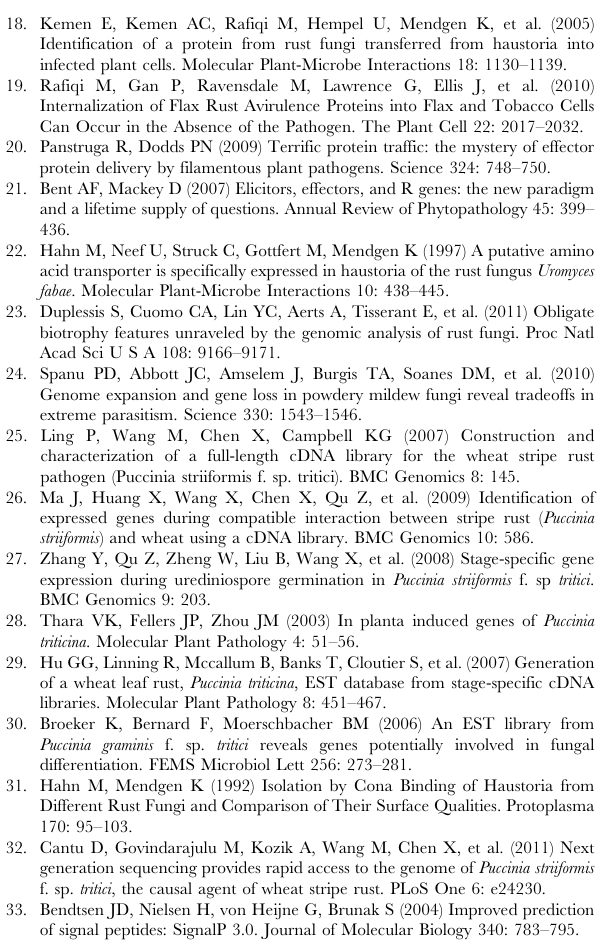
oxidative phosphorylation, and their in silico expression levels based on Illumina data are presented (RPKM values, green for haustoria and orange for germinated spores). Table S6 Gene expression values for the ontological analysis presented in Figure 4. Transcripts analysed with BLAST2GO and classed into different metabolic categories summarised in Figure 4 are listed in this table. The BLASTx values against the NCBI-nr protein database are included and their in silico expression levels based on Illumina data are presented (RPKM values, green for haustoria and orange for germinated spores). Transcripts highlighted in brown were excluded from the analysis due to low RPKM values ( , 10). Table S7 Illumina sequencing data before and after mapping against the transcripts reference set . Three biological replicates were sequenced with Illumina for isolated haustoria (H) and germinated spores (S). The table shows the millions of reads obtained per replicate and the percentage of reads mapping against the transcripts reference set assembled from 454 haustoria and germinated spore data. Table S8 List of primers to validate candidate effector gene expression by non-quantitative